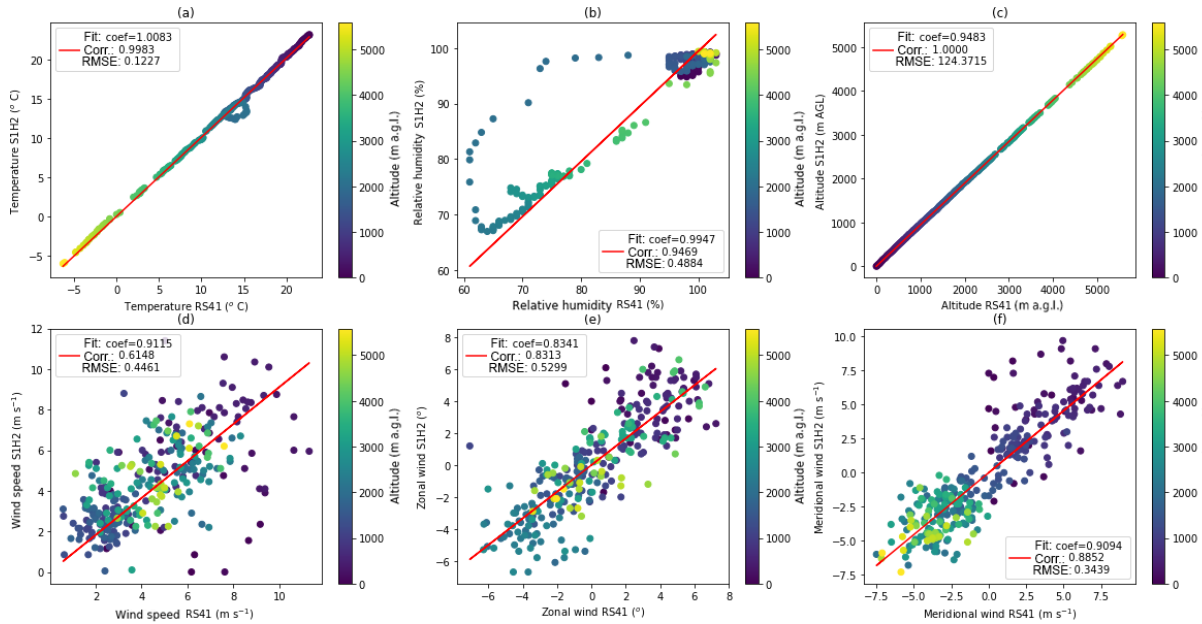
Figure 5. Comparison of temperature (a) , relative humidity (b) , altitude (c) , wind speed (d) , zonal winds (e) , and meridional winds (f) recorded by the Windsond S1H2 and the Vaisala RS41-SG during the flight of 28 June 2016, 05:44UTC in Kumasi. The colours are based on the Vaisala RS41-SG-measured altitude with the maximum altitude set to 6000m. The red lines indicate the linear regression of each parameter.